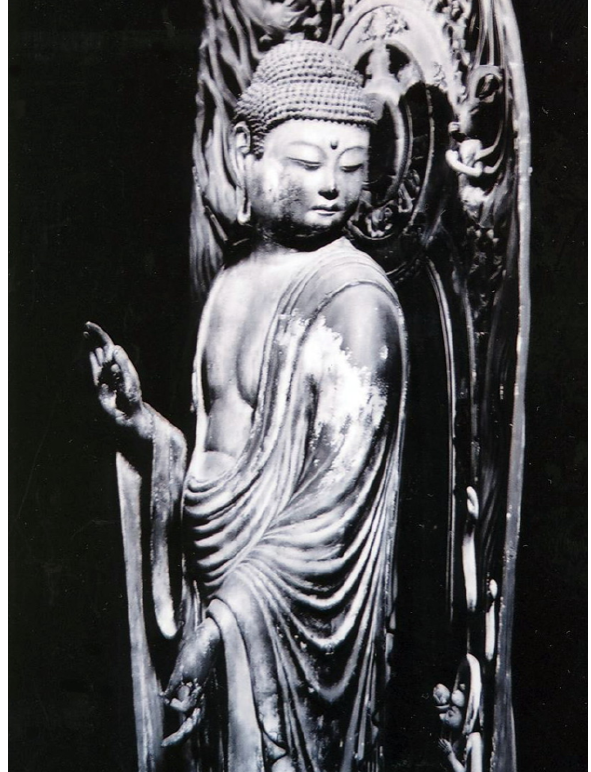
Figure 5: The Mikaeri Amida (Amitabha Looking Back) deity at Zenrin-Ji in Kyoto